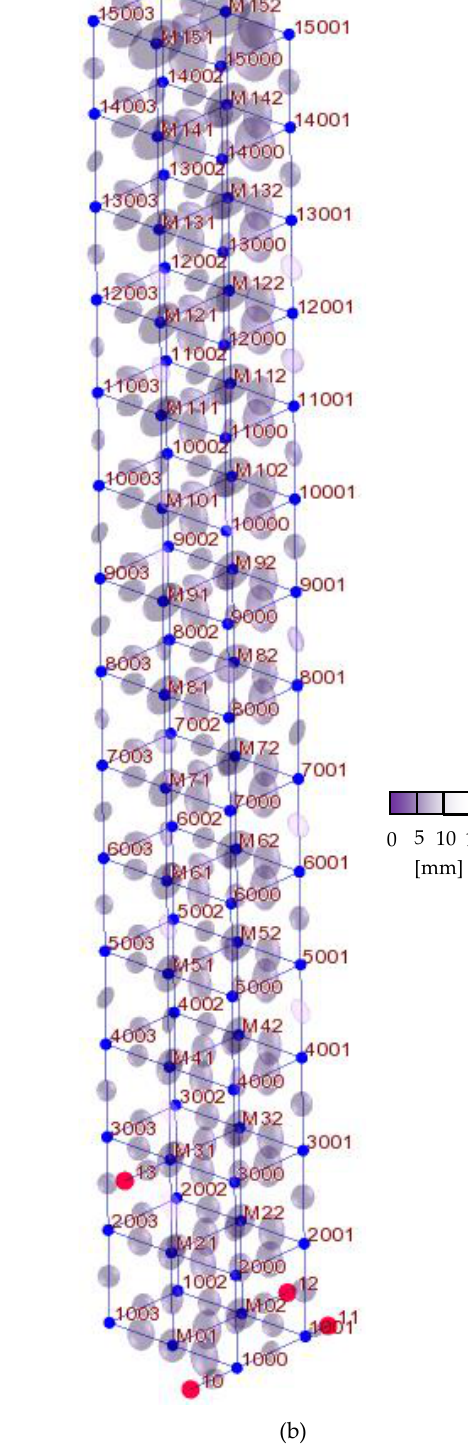
Figure A2. The relative error ellipses of coordinate determination ( a ) with additional GNSS observations; ( b ) without additional GNSS observations.